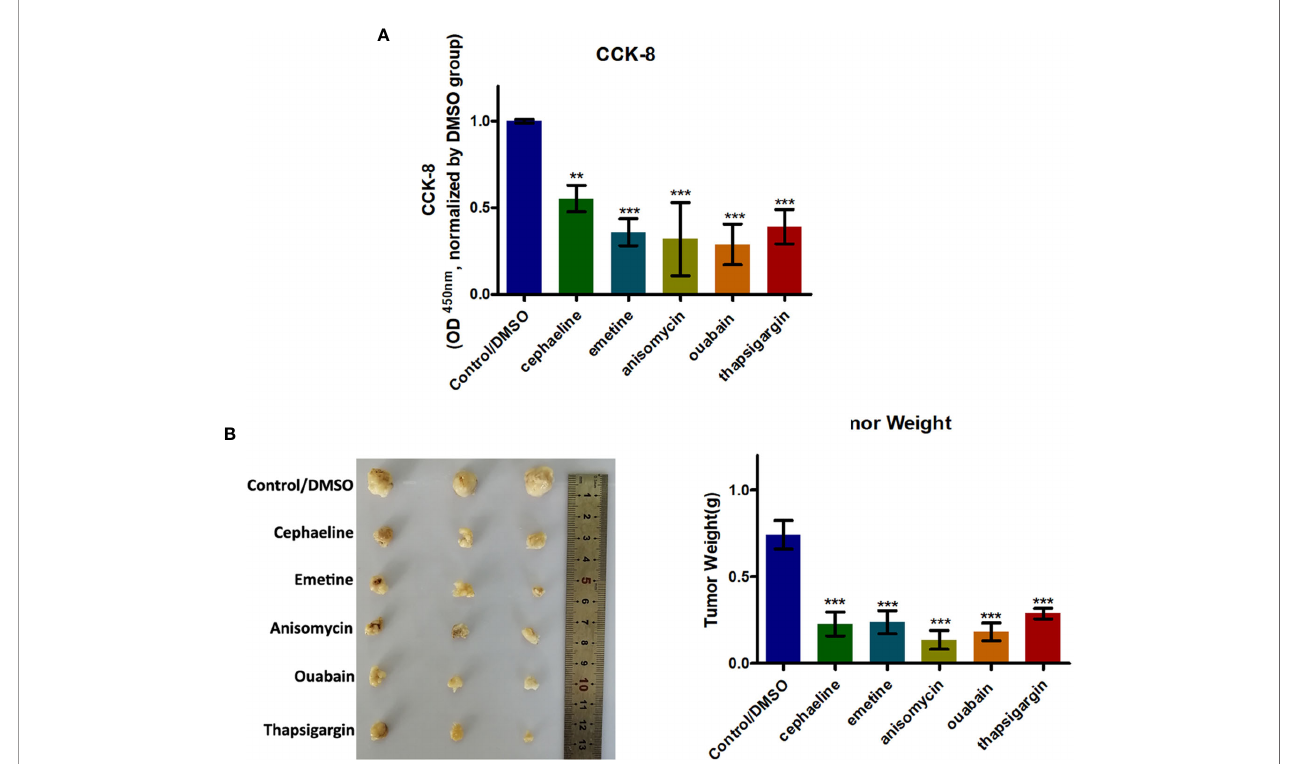
FIGURE 8 | Five potential drugs based on the PTC m5C-score model could impair growth of PTC cells. (A) Histogram showing the viability of PTC cells with or without fi ve potential drugs (cephaeline, emetine, anisomycin, ouabain, and thapsigargin) for 48 h at 20 m M. (B) BALB/c mice were subcutaneously injected with PTC cells. After 5 days, the nude mice were treated with cephaeline, emetine, anisomycin, ouabain, or thapsigargin (100 mg/kg daily, intraperitoneal injection). Tumor weights were measured after 6 weeks ( n = 5 mice/group). ***statistical signi fi